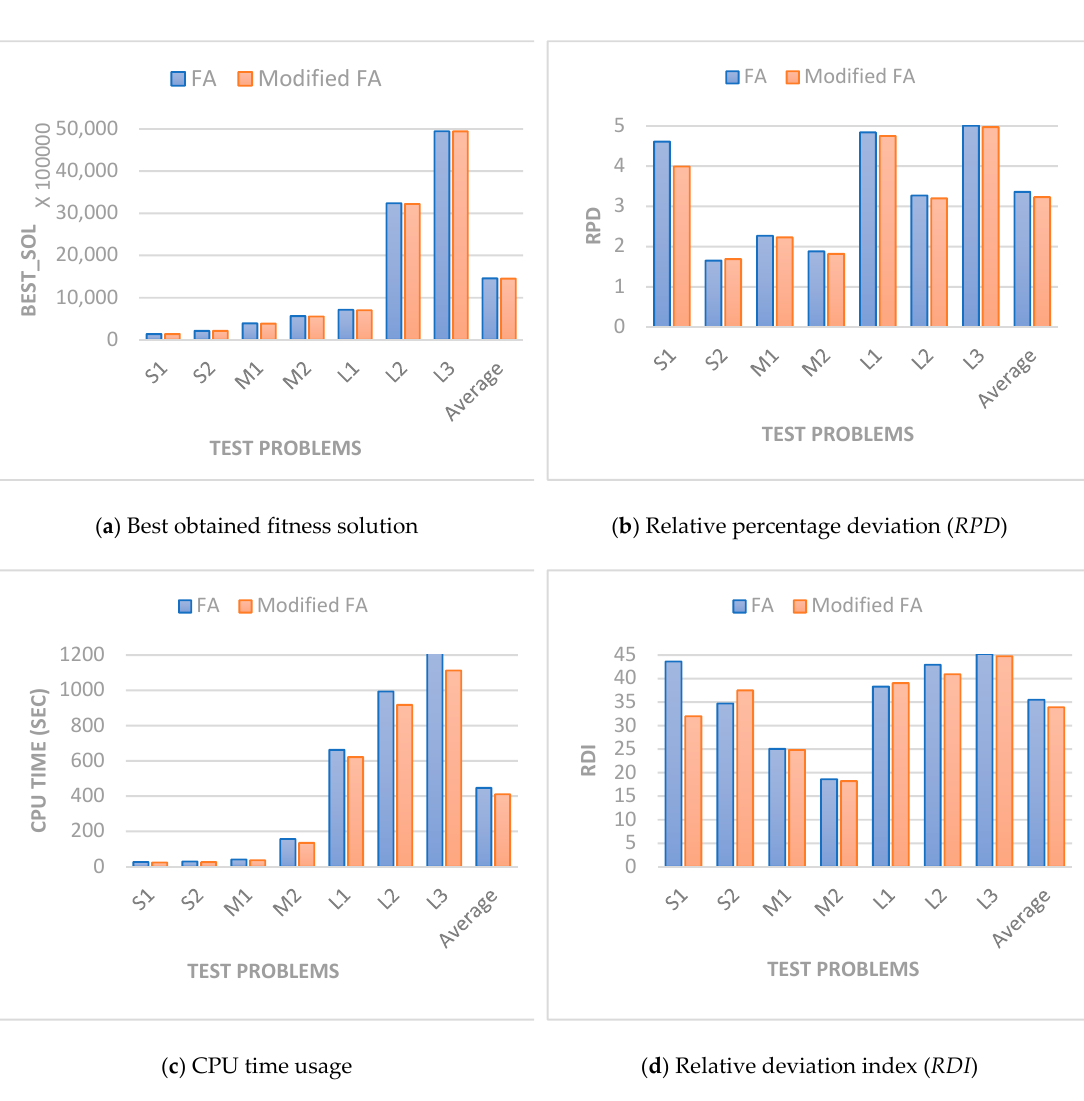
Figure 5. Performances comparison of modified FA and FA.